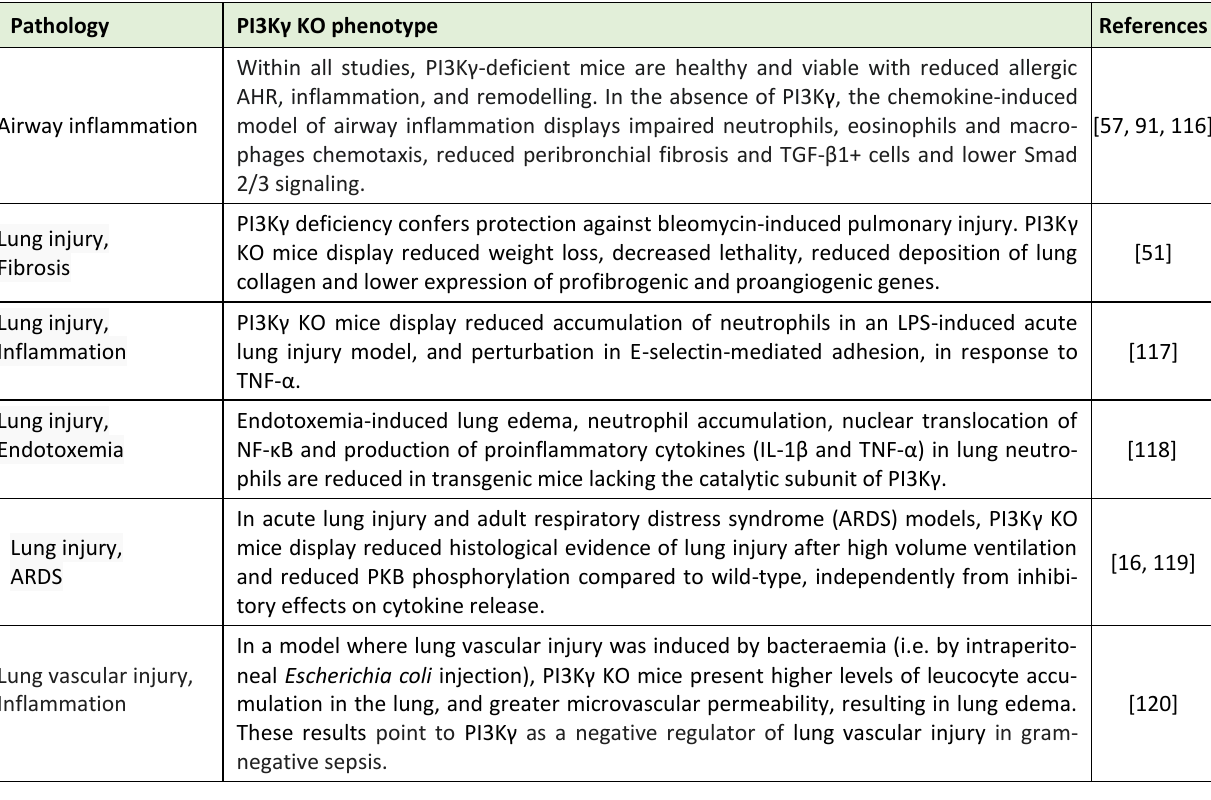
TABLE 1. Differential responses of PI3Kγ KO mouse models of respiratory diseases .